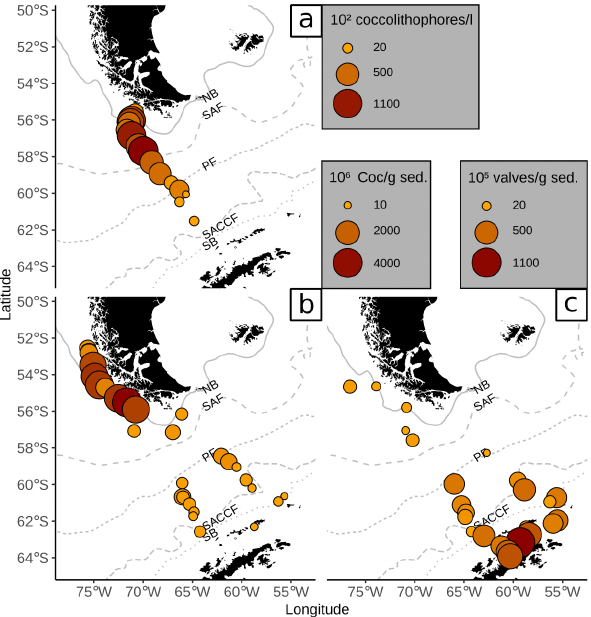
Figure 7. Comparison of (a) coccolithophore counts in plankton samples (mean over all water depths as coccolithophores per litre × 10 2 , Saavedra-Pellitero et al., 2019) with (b) coccolith counts in surface sediments (in Coc/g sed. × 10 6 , this study) and (c) diatom valve counts in surface sediments (in valves per gram sediment × 10 5 , Cárdenas et al., 2019). ACC fronts from north to south: NB (Northern Boundary), SAF (Subantarctic Front), PF (Polar Front), SACCF (Southern ACC Front) and SB (Southern